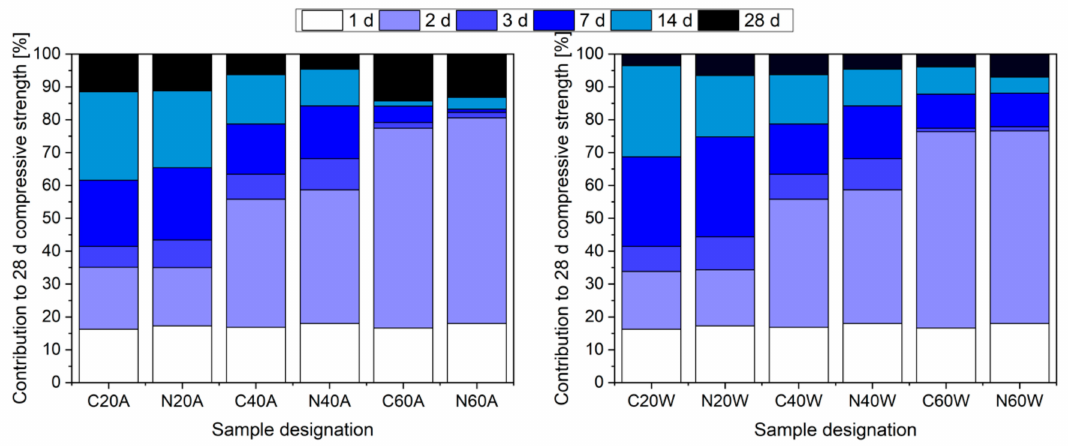
Figure 7. Development of strength of hot air-cured ( left ) and hot water-cured specimens ( right